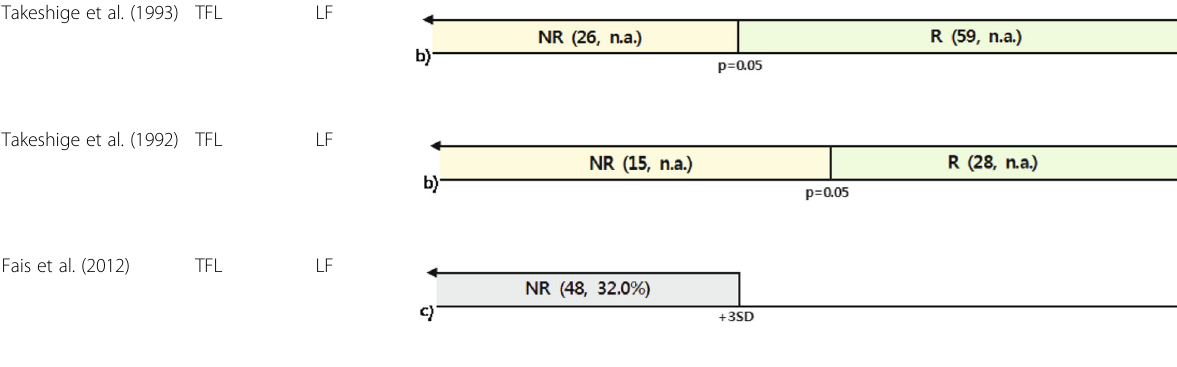
Table 3 EA response criteria and associated data (Continued) Takeshige et al. (1993)